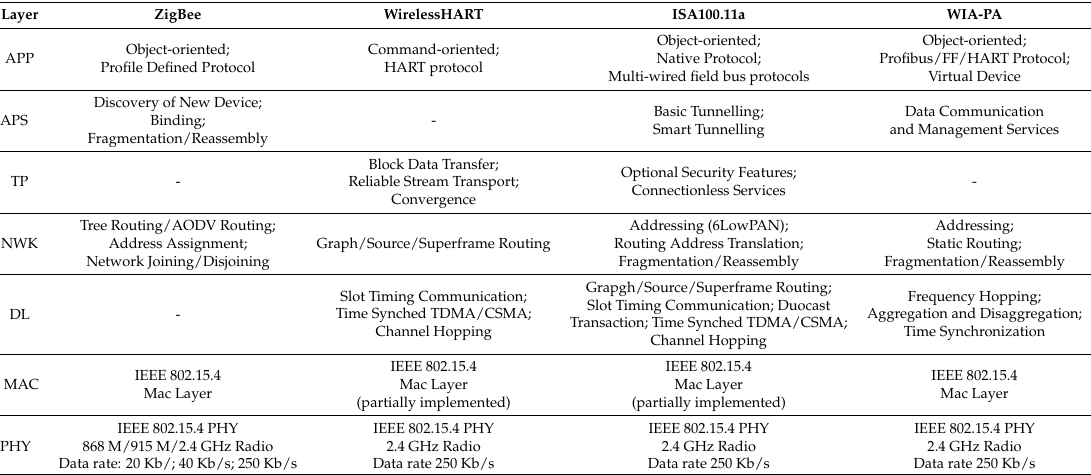
Table 1. Summary of main features, adapted from [9] and